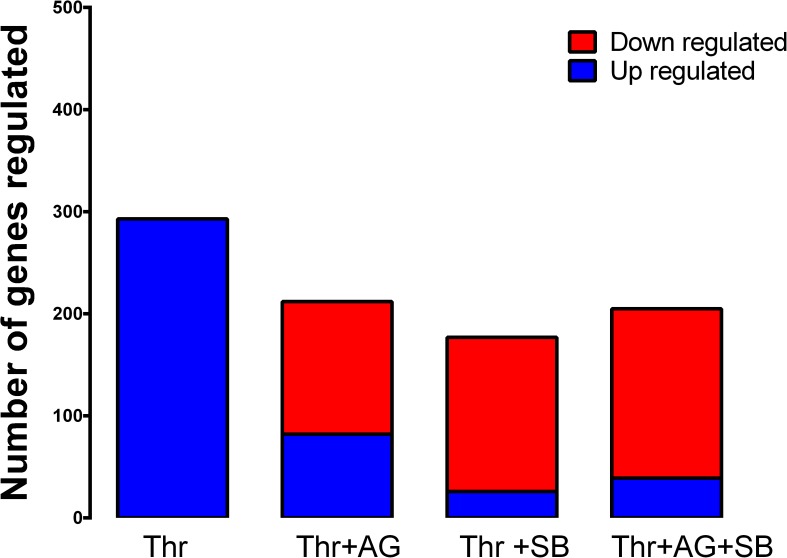
Number of genes regulated by thrombin transactivation of the EGFR and TGBR1 or both in vascular smooth muscle cells.Thrombin compared to basal treatment has a total of 293 genes up regulated. Thrombin transactivation of the EGFR denoted by thrombin in the presence of EGFR antagonist AG1478 has a total of 209 genes differentially regulated (80 up regulated and 129 down regulated). Thrombin transactivation of TGFBR1 denoted by thrombin in the presence of TGFBR1 antagonist SB431542 has a total of 177 genes differentially regulated (26 up regulated and 151 down regulated). Thrombin transactivation of both EGFR and TGFBR1 results in 212 genes differentially regulated (46 up regulated and 166 down regulated).